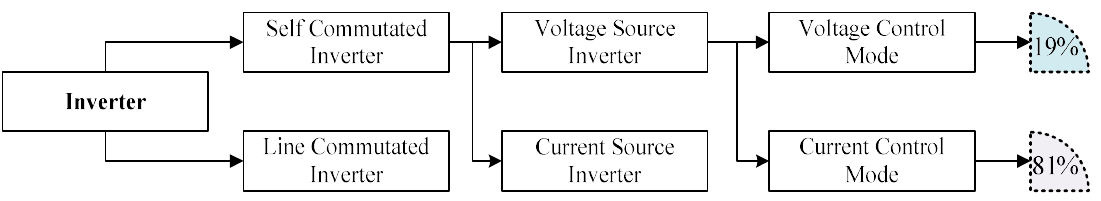
Figure 3. Classification of inverters [36].